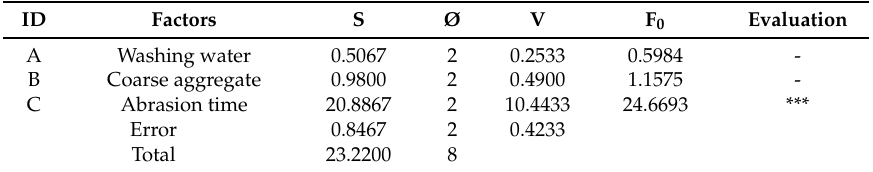
Table 8. Variance analysis for the solid volume of recycled fine aggregate.